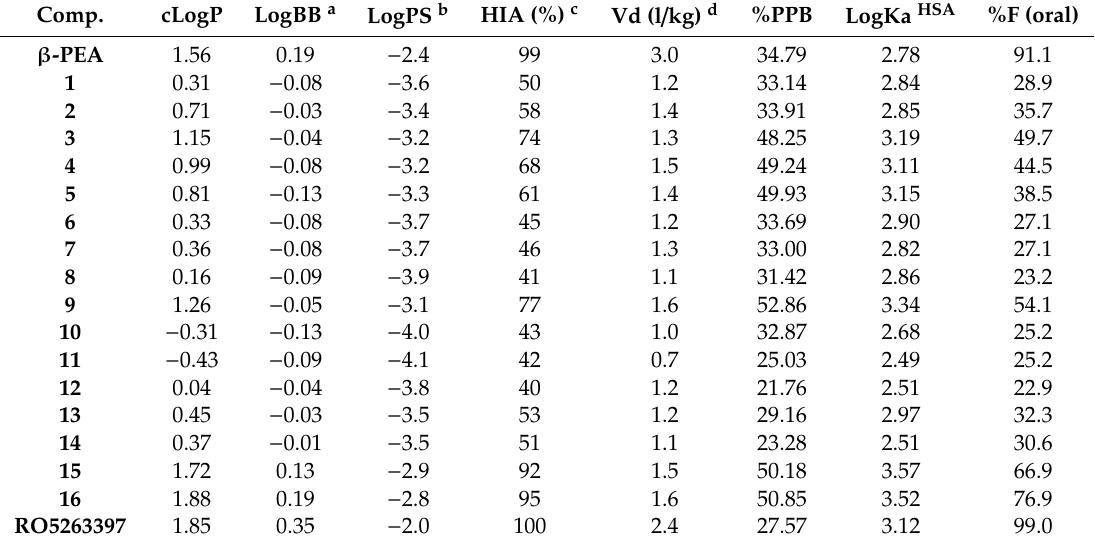
Table 3. Calculated absorption, distribution, metabolism, excretion and toxicity properties (ADMET) descriptors related to absorption and distribution properties. The most promising amidine-containing derivative 15 has been highlighted in yellow, as well as the reference compounds β -PEA and RO5263397. The other most interesting analogues, 2 , 6 , 9 and 16 , are shown in light cyan. The only one derivative predicted as unable to pass the blood–brain barrier (BBB) is reported in gray.